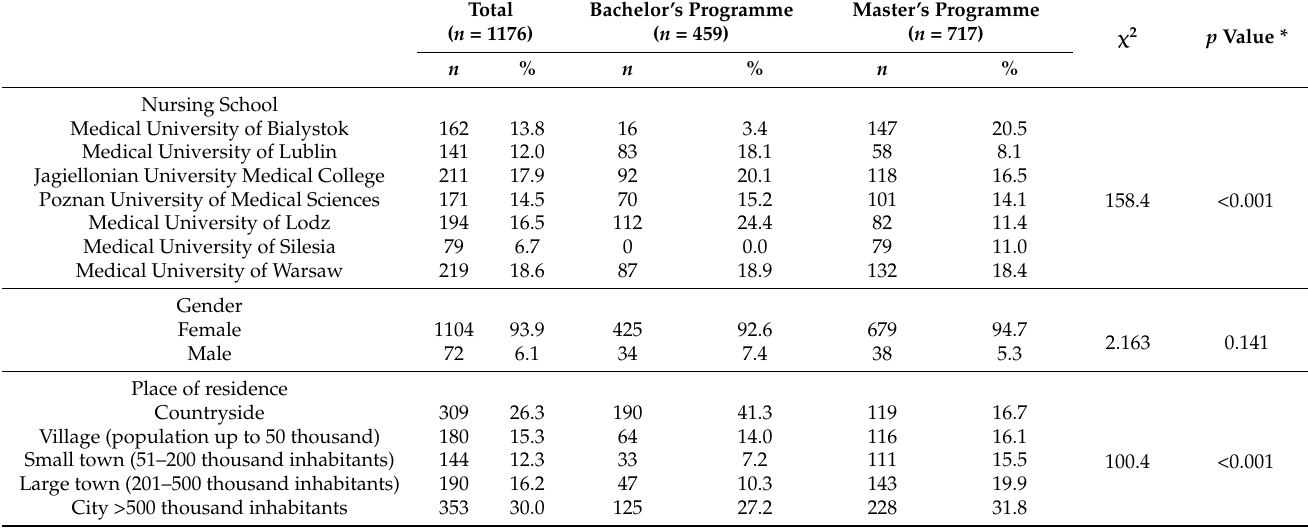
Table 1. Participant characteristics.